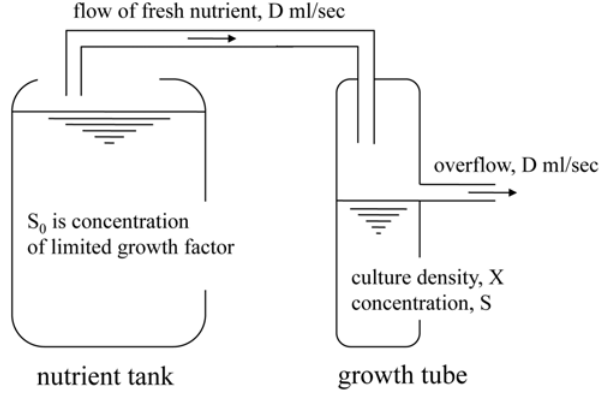
Figure 2. Schematic of a chemostat. In the chemostat, cells are grown in liquid media [14]. A tank contains a large supply of nutrient containing high concentrations of all growth factors, but a limited concentration (S 0 ) of the controlling growth factor. The nutrient flows continuously into a growth tube of limited capacity, where the culture grows. The dynamic behavior of the density of the culture (X) and of the concentration of the controlling nutrient (S) in the growth tube is summarized with a system of Michaelis-Menten differential equations. The desired growth rate is attained by manually limiting the concentration of the controlling growth factor in the nutrient provided to the cells.